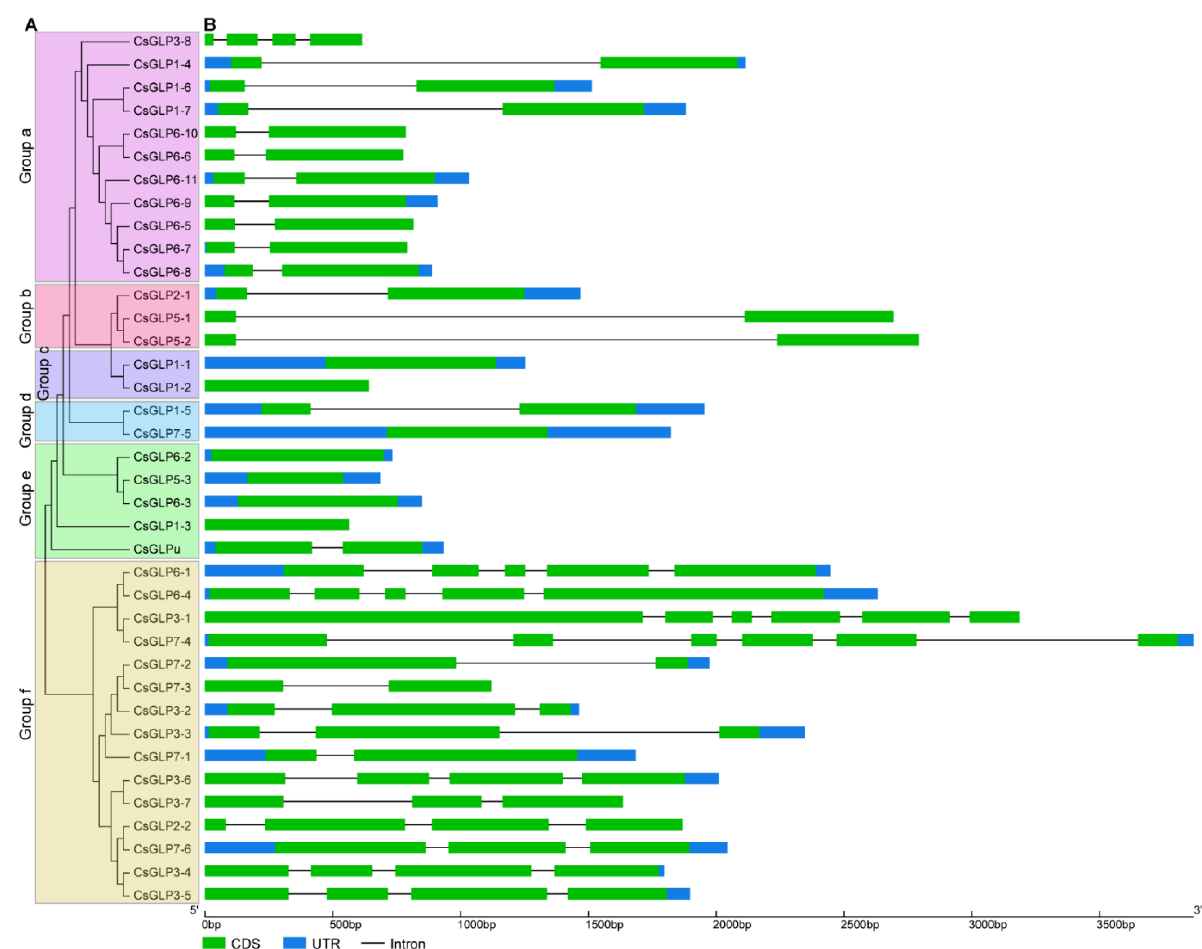
Figure 3. Phylogenetic relationship ( A ) and gene structure ( B ) of cucumber GLP family members. ( A ) The phylogenetic tree of CsGLP proteins was created using the NJ method with 1000 bootstrap replicates, and CsGLP proteins were divided into six groups (Groups a–f). ( B ) Gene structures of CsGLP genes analyzed by GSDS. Green box: CDS; Blue box: UTR; Black line: intron.